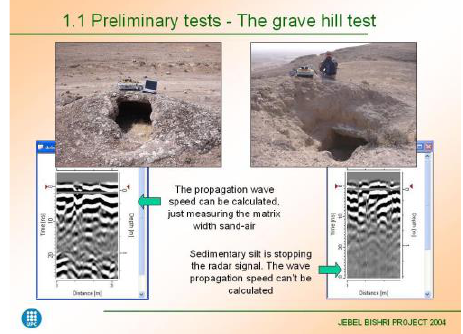
Figure 13. Studying tumuli of pastoral nomads on Jebel Bishri by GPR. Analyses by J.